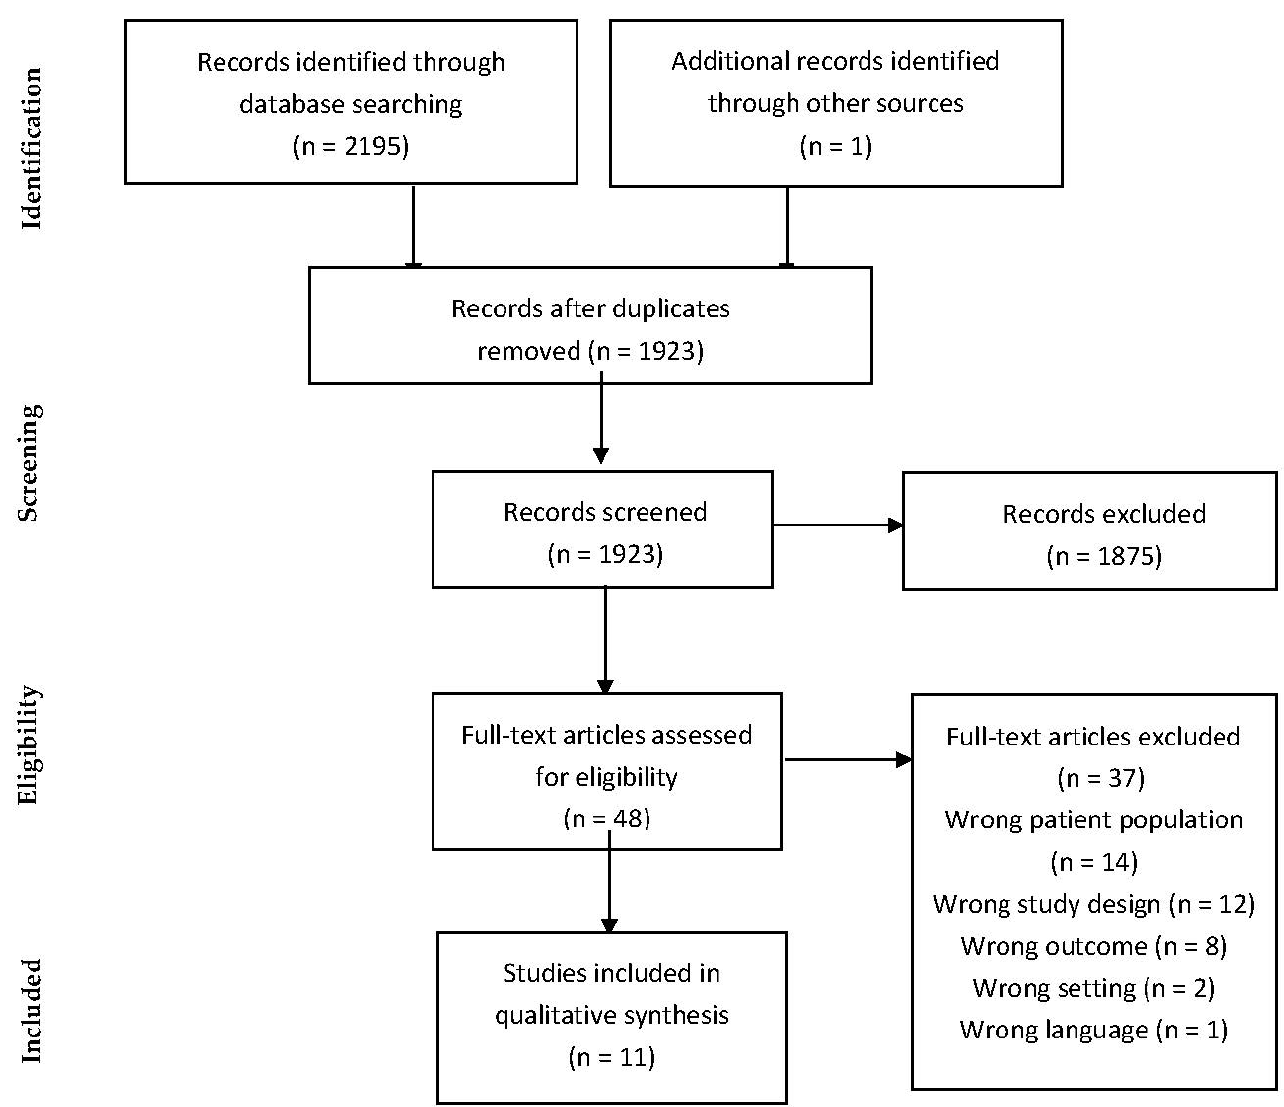
Figure 1. Preferred Reporting Items for Systematic Reviews and Meta-Analyses (PRISMA) flow diagram.